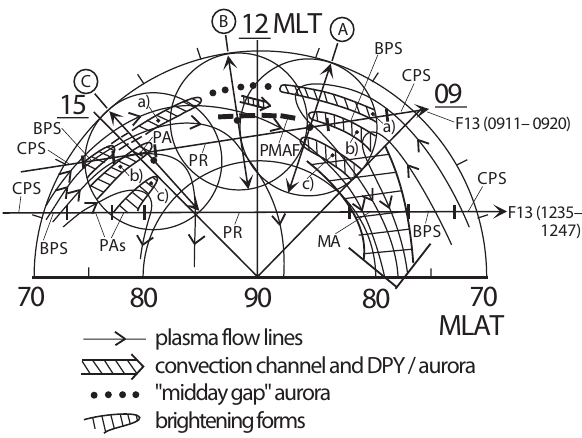
Figure 16 Fig. 16. Schematic illustration of auroral observations in relation to plasma convection for 12 December 1999 (case 2) in MLT/MLAT coordinates. Auroral forms appearing within the FOV of the optical instruments in Ny ˚Alesund are shown by hatching for the following intervals: 07:10–07:30 UT (A) , 09:10–09:30 UT (B) , and 11:10– 11:30 UT (C) . Convection channel on the dawn side of the polar cap is marked by broad arrow. Particle precipitation regimes along two DMSP F13 tracks are